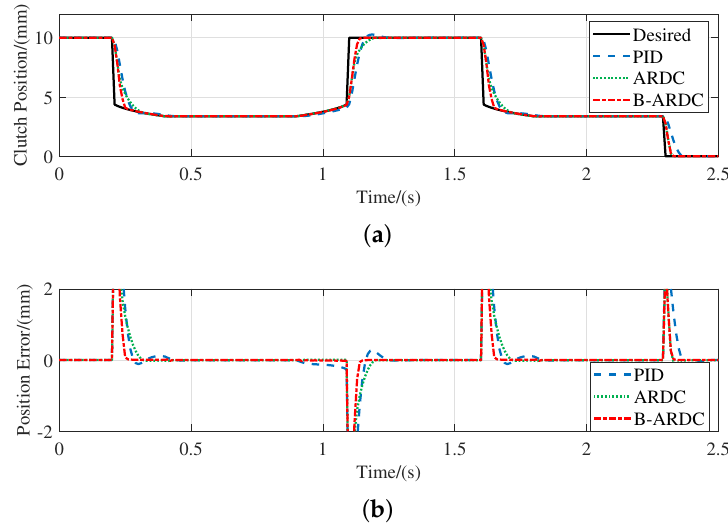
Figure 15. Performance comparison of position loop controllers under the second simulation condi- tion: ( a ) Clutch Position; ( b ) Position Error.